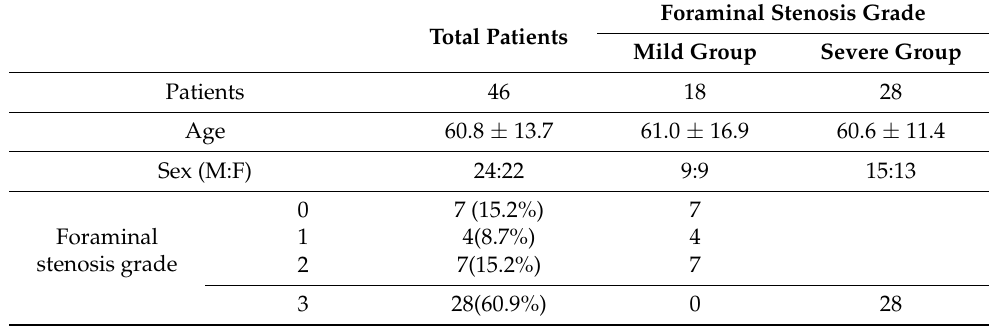
Table 1. Demographic